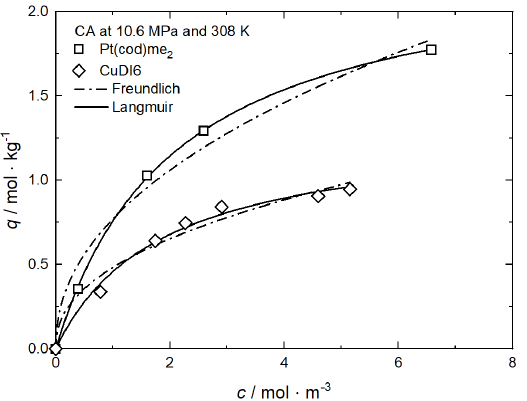
Figure A17. Uptake of different precursors on CA at 10.6 MPa and 308 K; experimental data taken from [58]. Table A17. Adsorption isotherm parameters of different precursors from scCO 2 solution on CA at 10.6 MPa and 308 K [58].